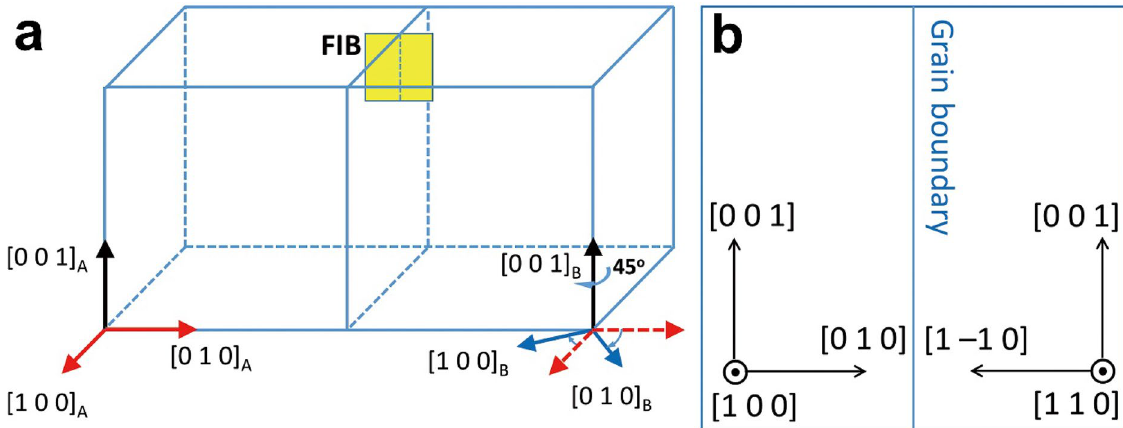
Figure 1. ( a ) Three-dimensional sketch showing crystallographic directions of the Cu bicrystal composed of two grains with a misorientation relationship of [0 0 1]/45°. ( b ) Illustration of crystallographic directions of an FIB specimen extracted from the GB area in the